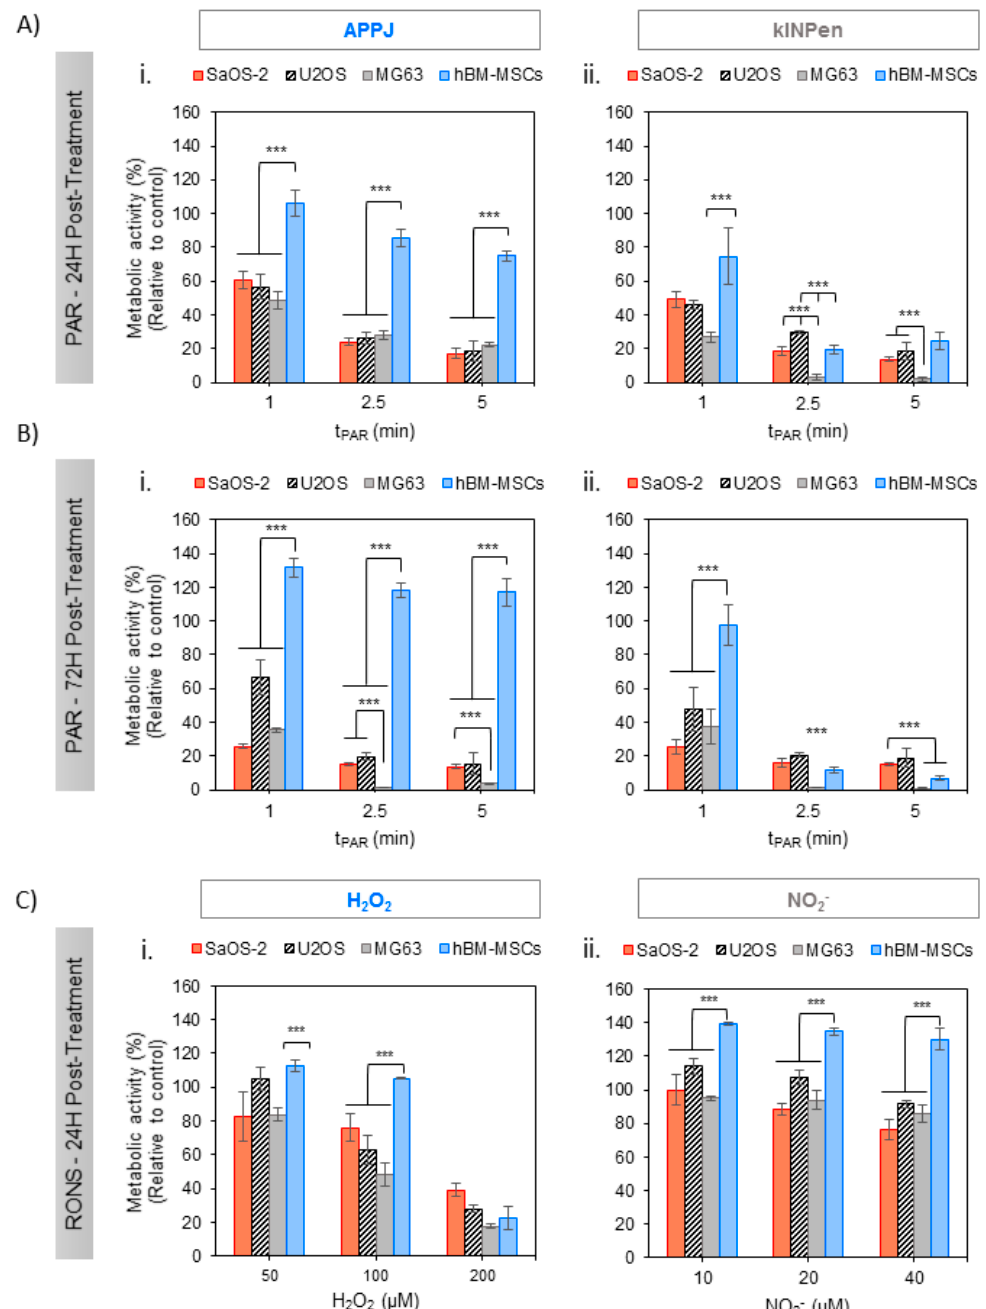
Figure 2. E ff ects of PAR on the metabolic activity of human OS cell lines (SaOS-2, MG-63, U2-OS) and healthy hBM-MSC with treatment time. Cells in adherent culture were exposed during 2 h to PAR treated by APPJ or kINPen for 1, 2.5 and 5 min. After that, PAR was replaced by fresh medium. Metabolic activity was determined 24 h ( A ) and 72 h ( B ) after PAR exposure by WST-1 test. ( C ) Cells were also exposed during 2 h to increasing concentrations of H 2 O 2 and NO 2 − standards in Ringer’s saline with 10% FBS (which match with concentrations determined in Figure 1), corresponding to 50, 100 and 200 µ M for H 2 O 2 ( Ci ) and 10, 20 and 40 µ M for NO 2 − ( Cii ) and metabolic activity was determined 24 h after exposure. Values were relativized to cells exposed to untreated PAR. Asterisks represent statistically significant di ff erences among cell lines for the same PAR treatment time-point. ( n = 3; *** p -value < 0.005, ANOVA and two-sided Student’s t